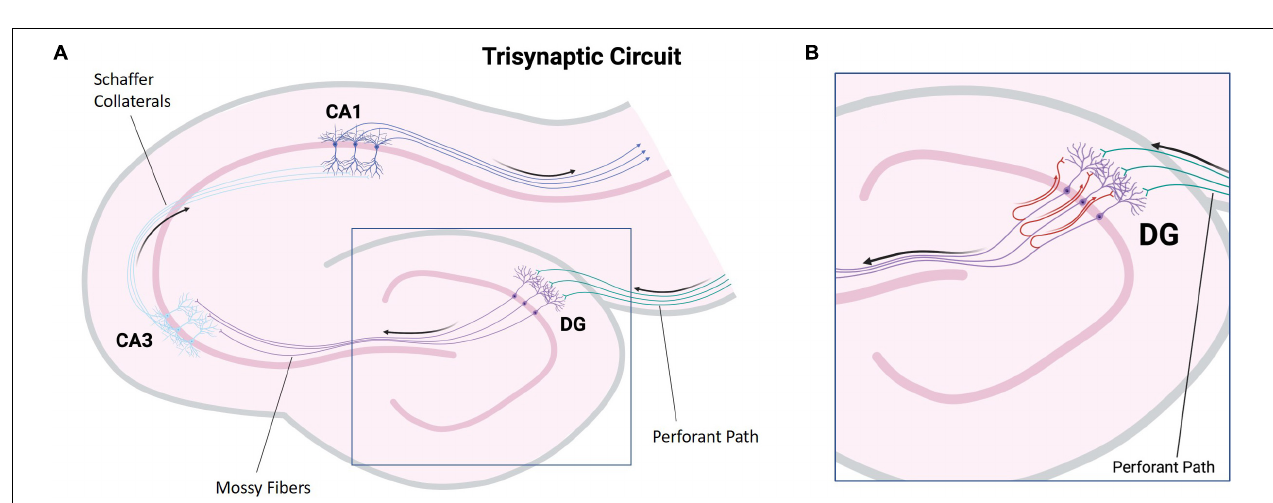
FIGURE 1 | Macro- and microscopic images of human temporal lobe and hippocampus. (A) Coronal section of the cerebral hemispheres at level of lateral geniculate nuclei. The boxed area shows hippocampus and the parahippocampal gyrus. (B) Hematoxylin, eosin, and Luxol fast blue prepared histology section of the boxed area in A . (C) A higher magnification view of the hippocampal proper. Dashed lines represent boundaries of CA sectors. (DG, dentate gyrus; CA1–CA4, sectors of Cornu ammonis.) Scale bar in B : 3 mm, C : 800 µ m. (Department of Pathology and Laboratory Medicine, London Health Sciences Centre, University Hospital, London, ON, Canada).